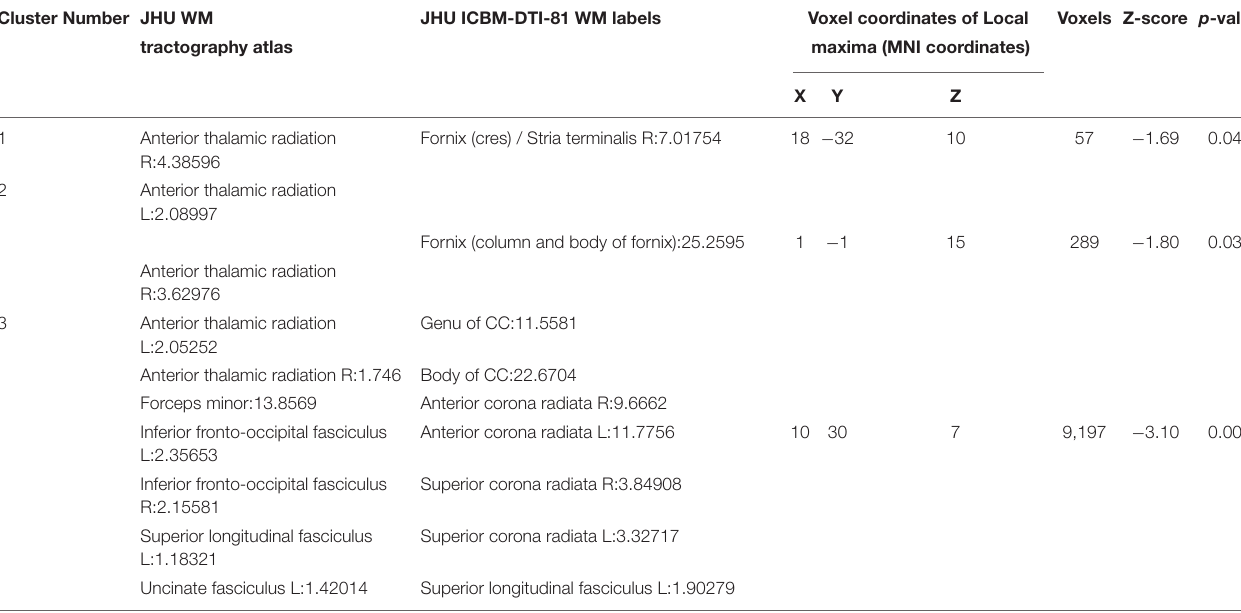
TABLE 2 | Cluster sizes and locations for voxels with significantly reduced FA in ESRD vs. NES-CKD groups. Cluster Number JHU WM Voxels Z-score p